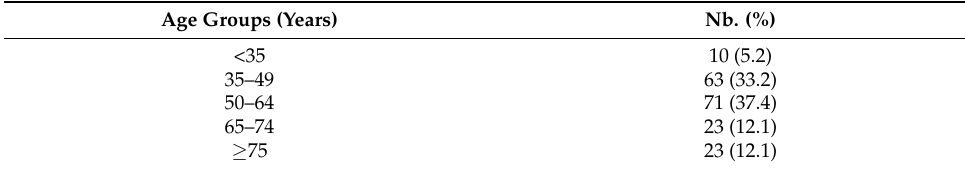
Figure 2. Examples of invasive breast carcinomas in diabetes or obese patients. ( A ) Invasive breast carcinoma NST SBR I shows tubular structures (arrow) consisting of cancer cells with moderate nuclear pleomorphism and low mitotic activity within a sclerotic but low inflammatory stroma (arrowheads: microcalcifications) (magnification ×200). ( B ) Invasive breast carcinoma NST with medullary features shows syncytial cell trabeculae with high nuclear pleomorphism within a TILs-rich stroma (arrowhead) (magnification ×330). ( C ) Invasive breast carcinoma NST SBR II shows no glandular structures (arrow) with moderate nuclear pleomorphism, and moderate mitotic activity, in a sclerotic stroma (magnification ×200). ( D ) Invasive lobular carcinoma shows cells organize in files (arrow) within an edematous stroma (magnification ×400). Table 2. Distribution of patients by age group ( n = 190).